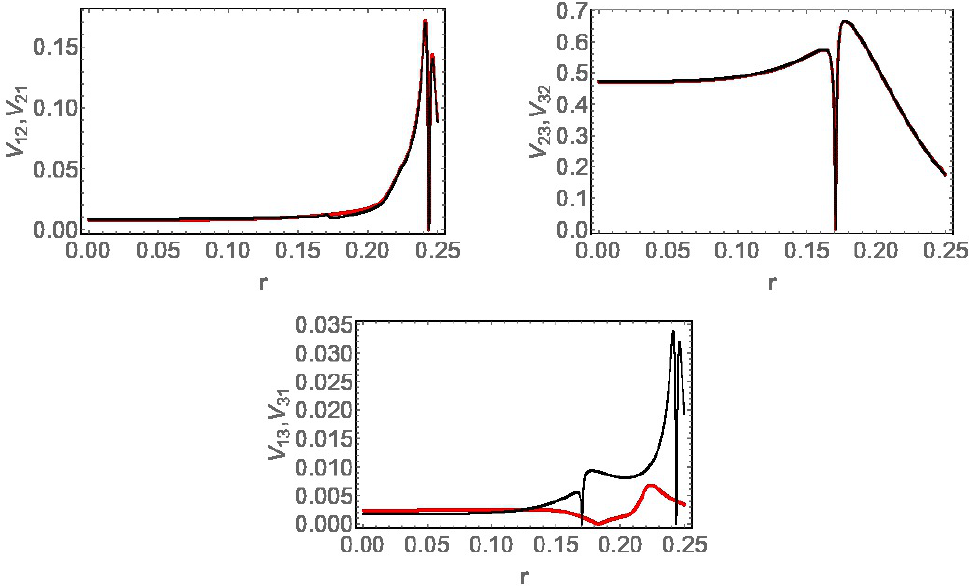
Figure 3 . The blow-up radius ( r )-dependence of the CKM mixing angles V 12 ( V 21 ), V 23 ( V 32 ), and V 13 ( V 31 ), as shown in the red (black)